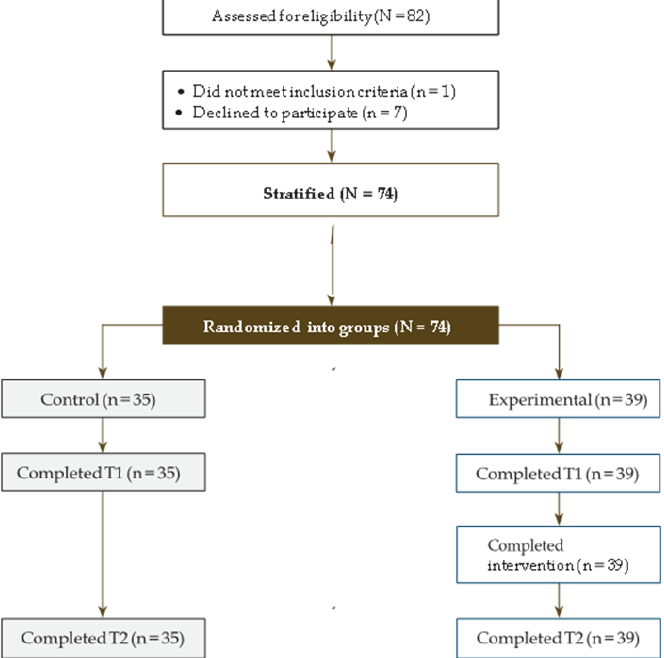
Figure 1. CONSORT trial participation at baseline (T0) and three months